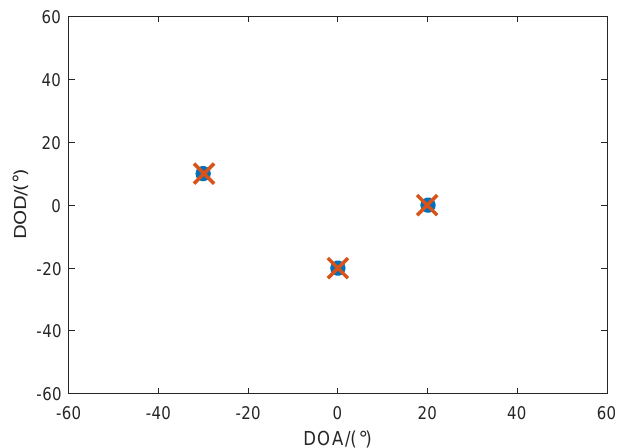
Figure 3. Estimation results of the proposed method with SNR = 0dB.